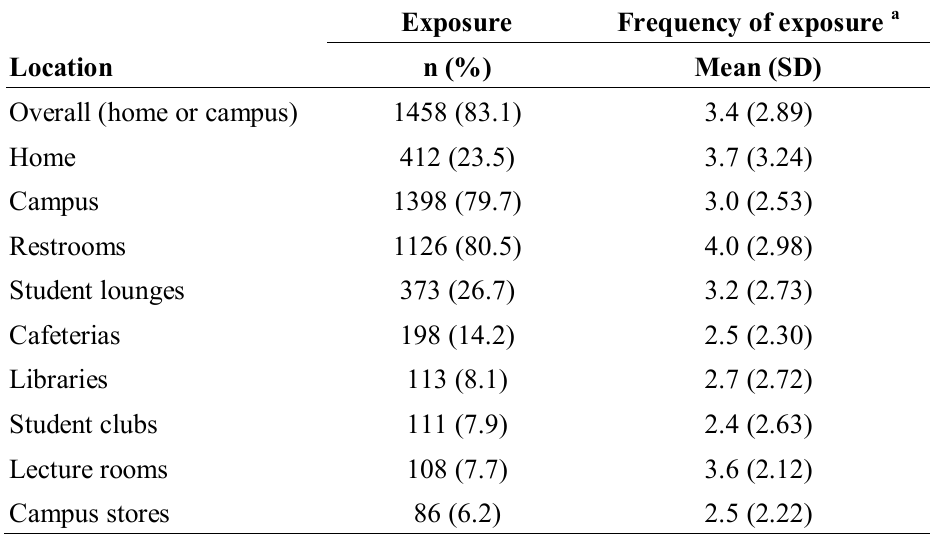
Table 2. Prevalence and frequency of secondhand smoke exposure (N = 1754). Exposure Frequency of exposure